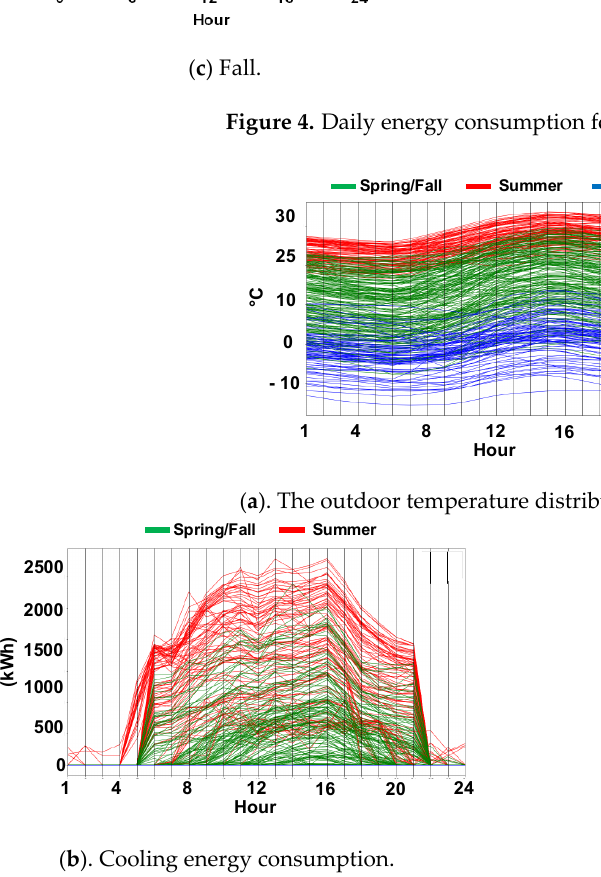
Figure 5. Daily weather data and cooling and heating energy consumption for three years.